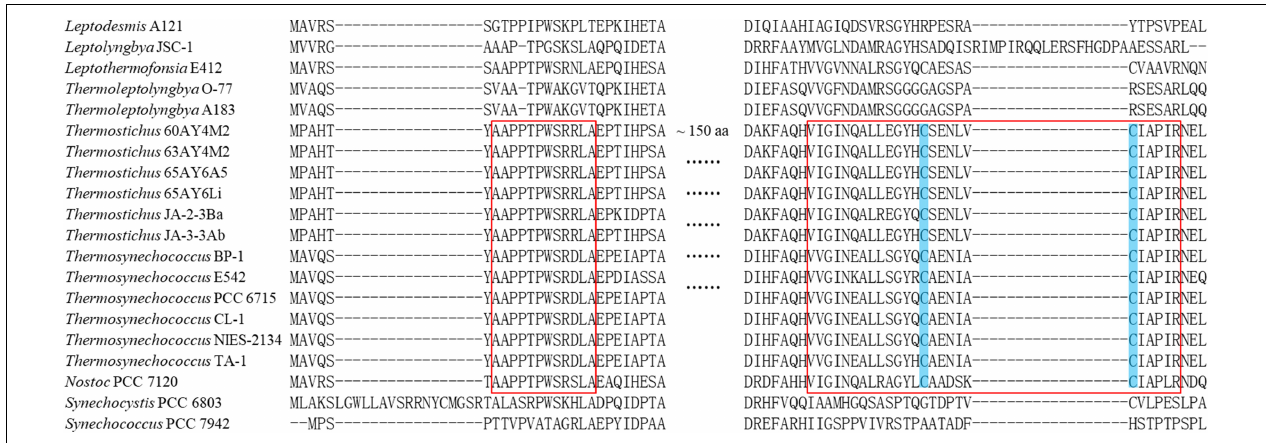
FIGURE 6 | Partial alignments of ccmM amino acid sequences representing 17 thermophilic cyanobacteria, Nostoc PCC 7120, and Synechocystis PCC 6803 and Synechococcus PCC 7942 as outgroup. As suggested by Peña et al. (2010), red boxes refer to conserved regions of the N-terminal domain of ccmM necessary for CA activity, while shaded cysteine amino acids indicate essential residues participating in the disulfide bond in the C-termini of active ccmM protein.